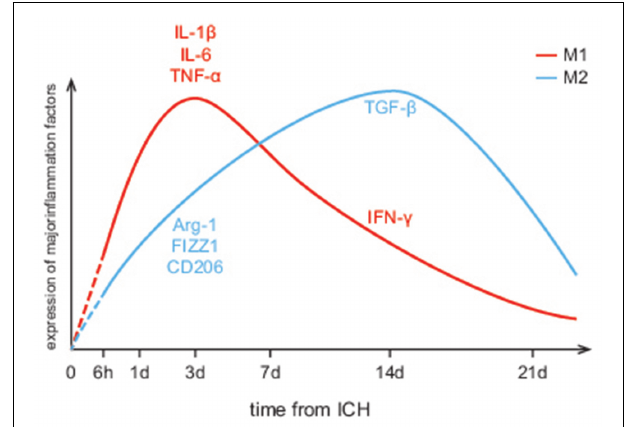
FIGURE 1 | Dynamic changes of M1/M2 microglial activation levels after intracerebral hemorrhage (ICH). It provides a visual expression that M1/M2 microglia take on different activation characteristics. The red curve represents M1 microglia while the blue curve represents M2 microglia. Yet, the referenced researches about microglial spatiotemporal features are all animal experiments, leaving the human brain as an unknown area.